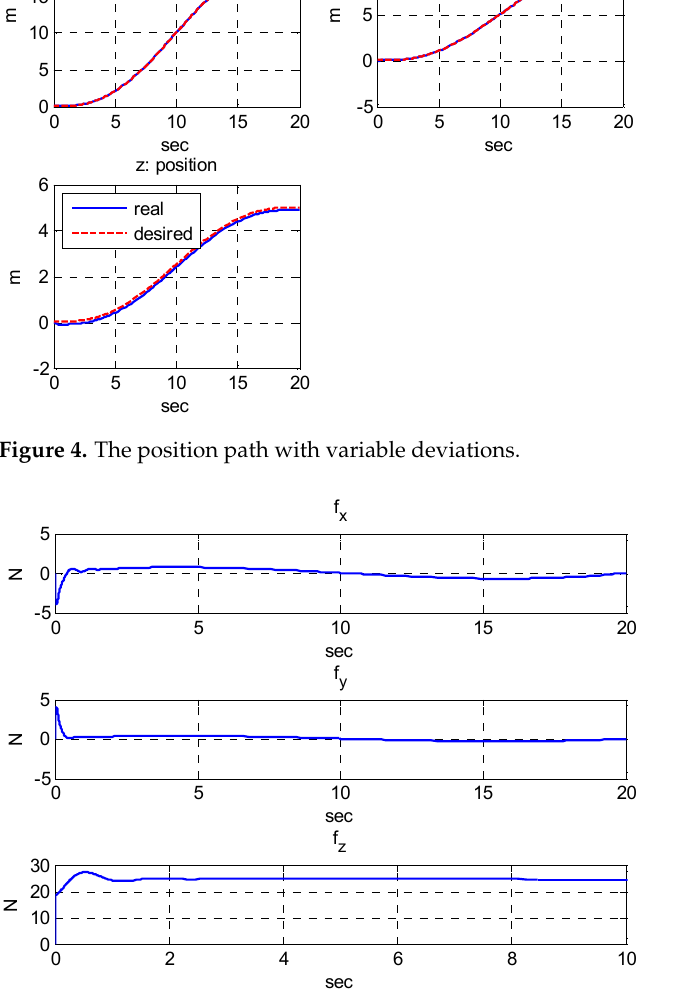
Figure 5. The propelling force with variable deviations.